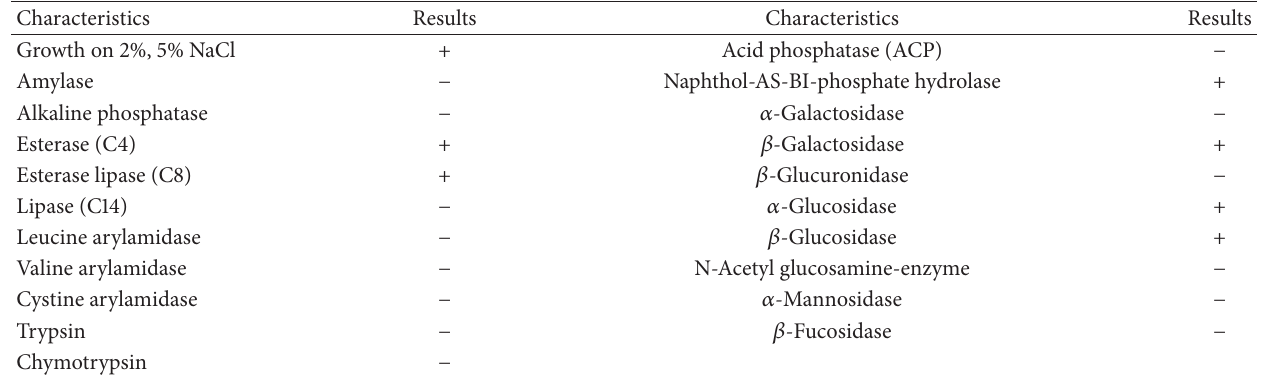
Figure 3: Phylogenetic positions based on neighbour-joining of the 16S rRNA gene sequence of the isolated rhizosphere strain, Suzhou 08+6. Table 2: The growth characteristics and enzyme activity of the isolated strain Suzhou